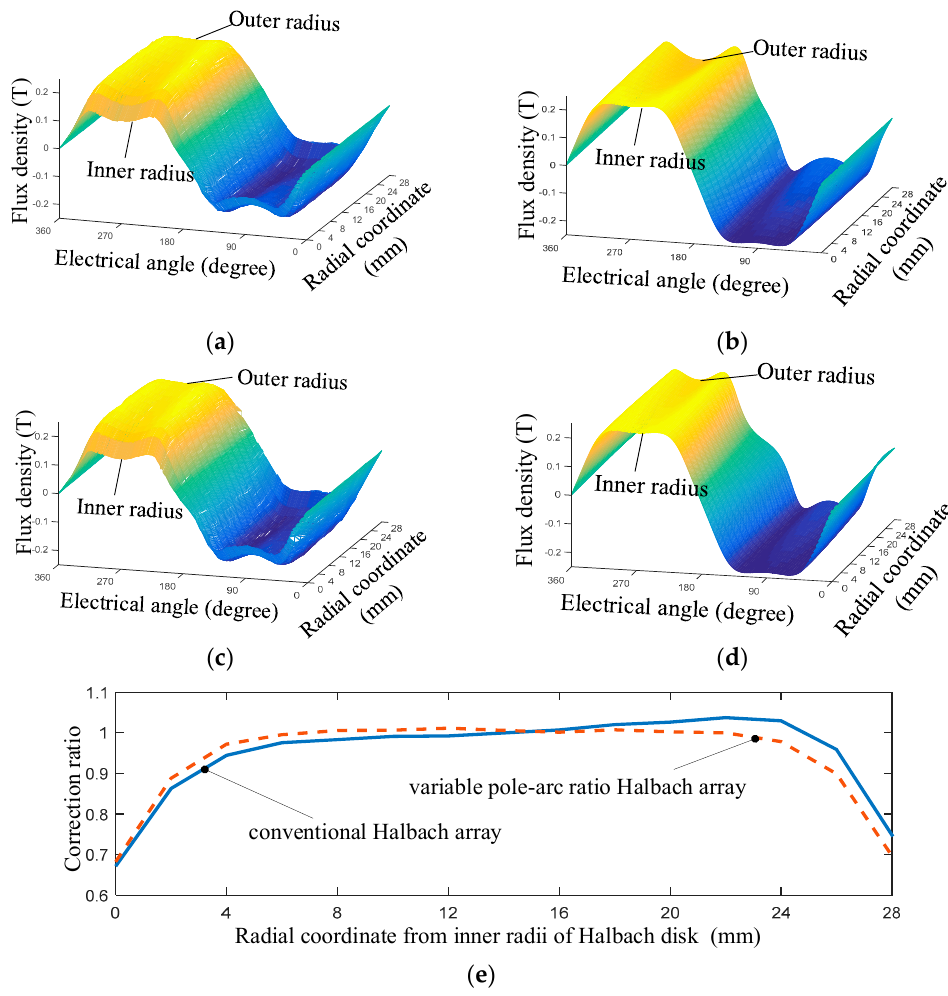
Figure 8. End-effects on the distribution of flux density and the corresponding correction function g ( r ): ( a ) 3-D FEM results of conventional Halbach array; ( b ) quasi-3-D results of conventional Halbach array; ( c ) 3-D FEM results of VPAR-DHA; ( d ) quasi-3-D results of VPAR-DHA; ( e ) g ( r ).